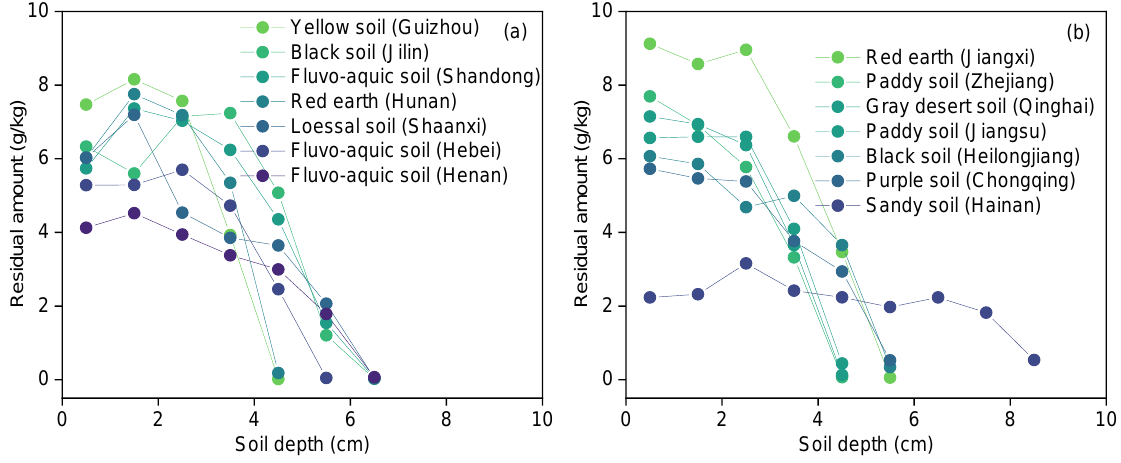
Figure 3. Residual amount of diesel in fourteen types of soils after 72 h.